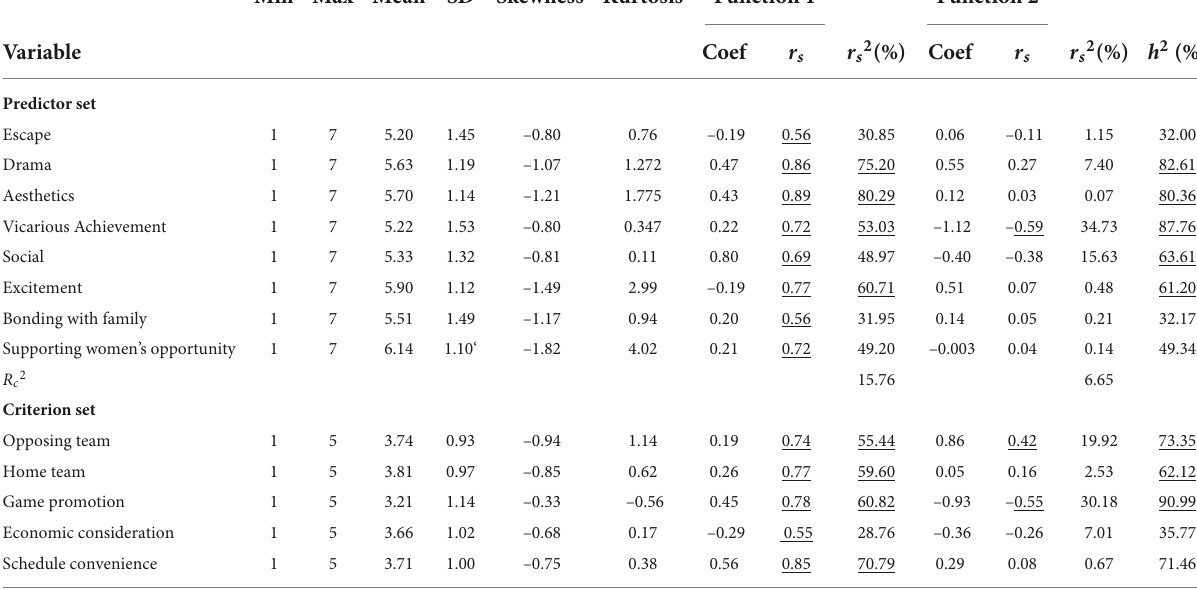
TABLE 3 Descriptive statistics and canonical solution for push factor predicting push factor for functions 1 and 2.